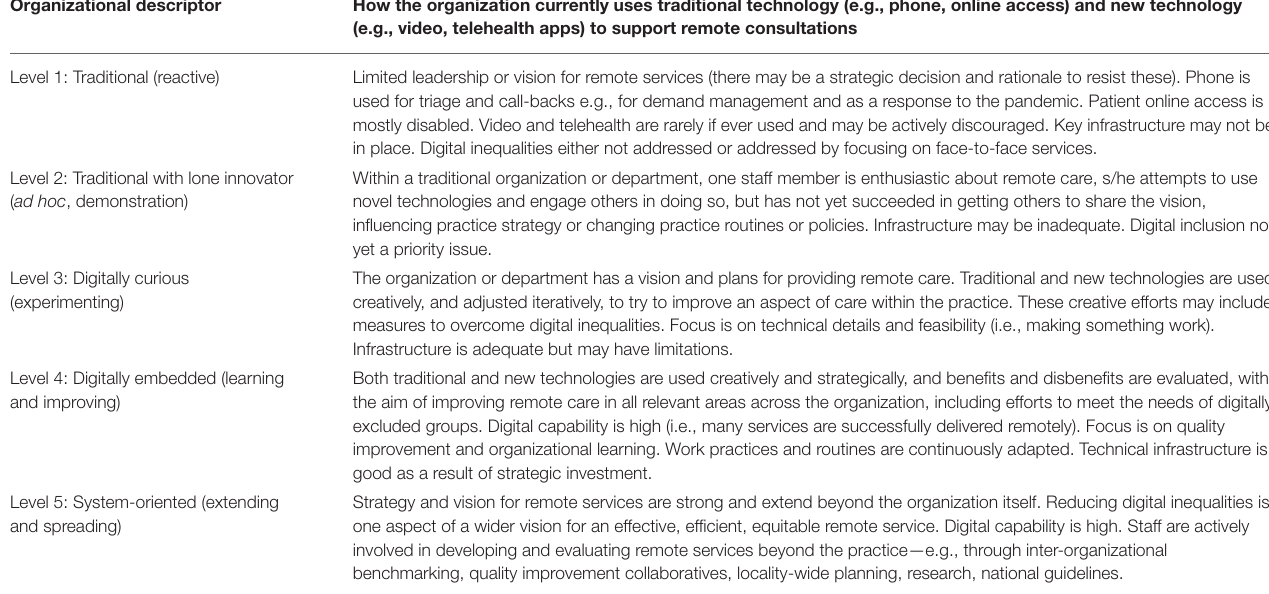
TABLE 2 | Digital maturity scale for healthcare organizations in relation to remote